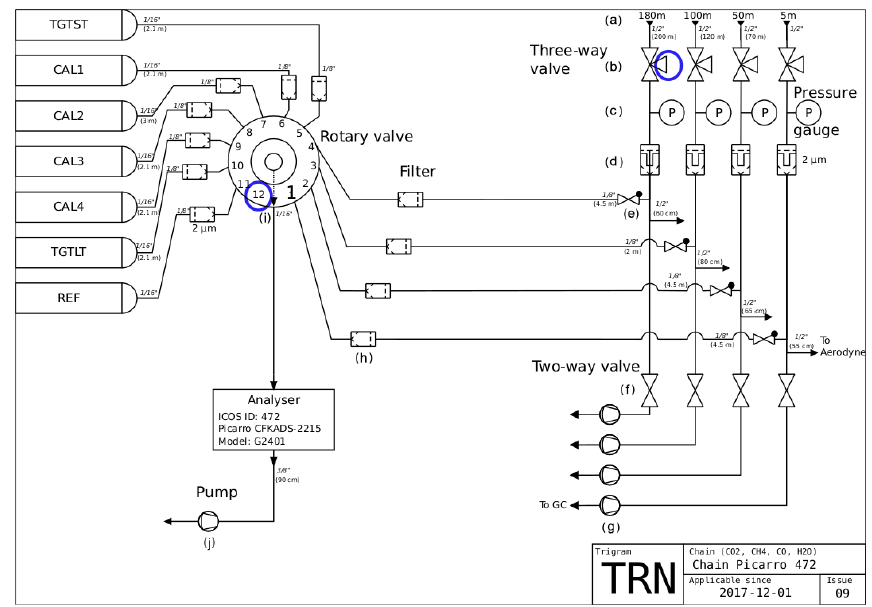
Figure 2. Station schematics with injection points in blue for the shelter test. Example of Trainou tower, France. Different parts include valves, filters, pressure gauges and pumps. One element of each type is given in the legend for